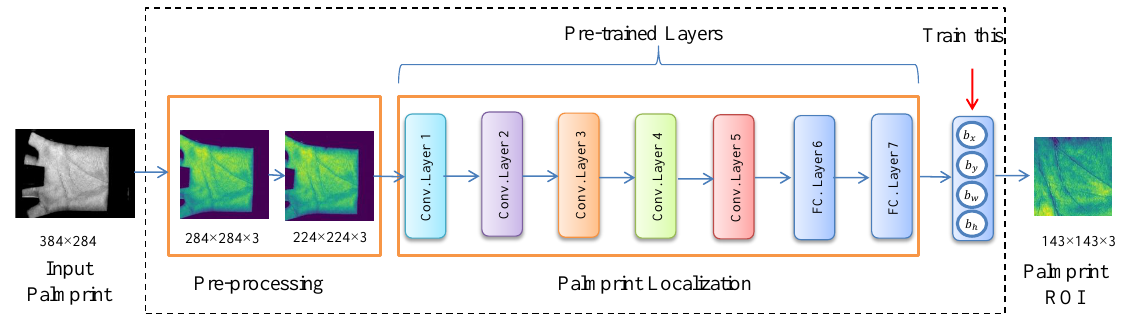
Figure 3. ROI extraction module. B x and B y : center point; B y : width and B h : high of the box containing the palmprint